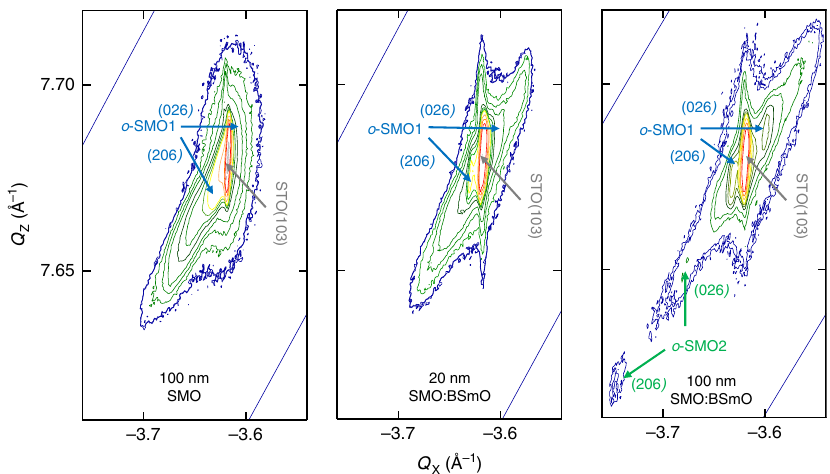
Fig. 4 Structural analysis. Asymmetric RSMs around the (113) re fl ection of STO. (206) and (026) re fl ections of orthorhombic SMO ( o -SMO1) appear clearly in the RSMs of three different fi lms con fi rming the presence of the o -SMO1 orthorhombic crystal domain structure. For the 100 nm SMO fi lm, the orthorhombicity is less than in the SMO:BSO VAN fi lms (as indicated by less splitting of the o -SMO1 peaks). The 100 nm SMO:BSO VAN fi lm shows an additional orthorhombic phase ( o -SMO2) indicated by the split peaks at lower Q z and higher Q X than the STO peak